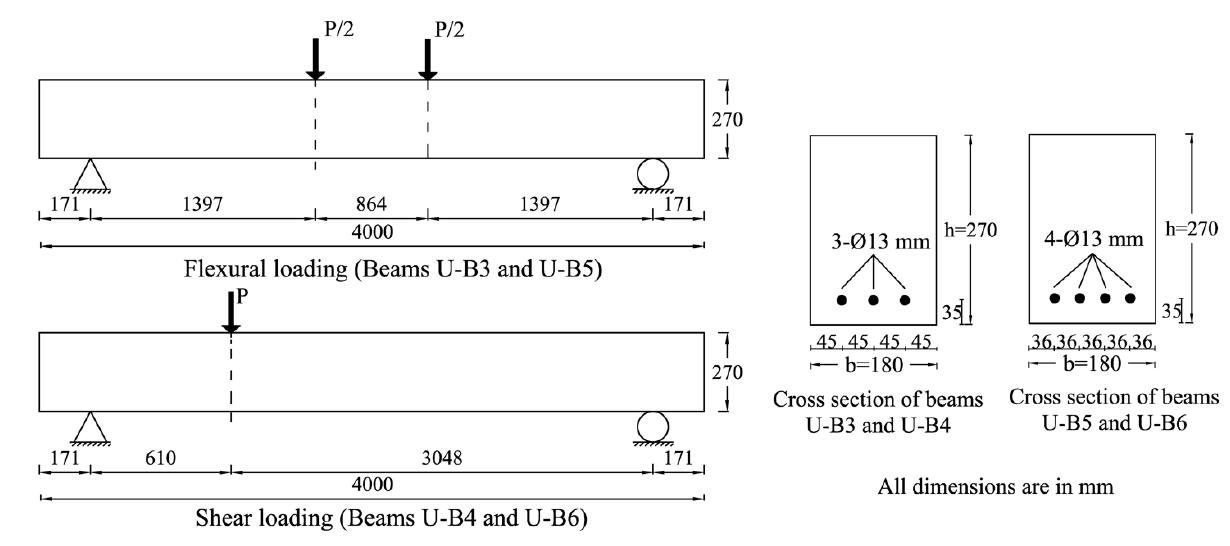
Figure 5. Test set-up, and cross sectional details of tested UHPFRC beams (data from [17]).